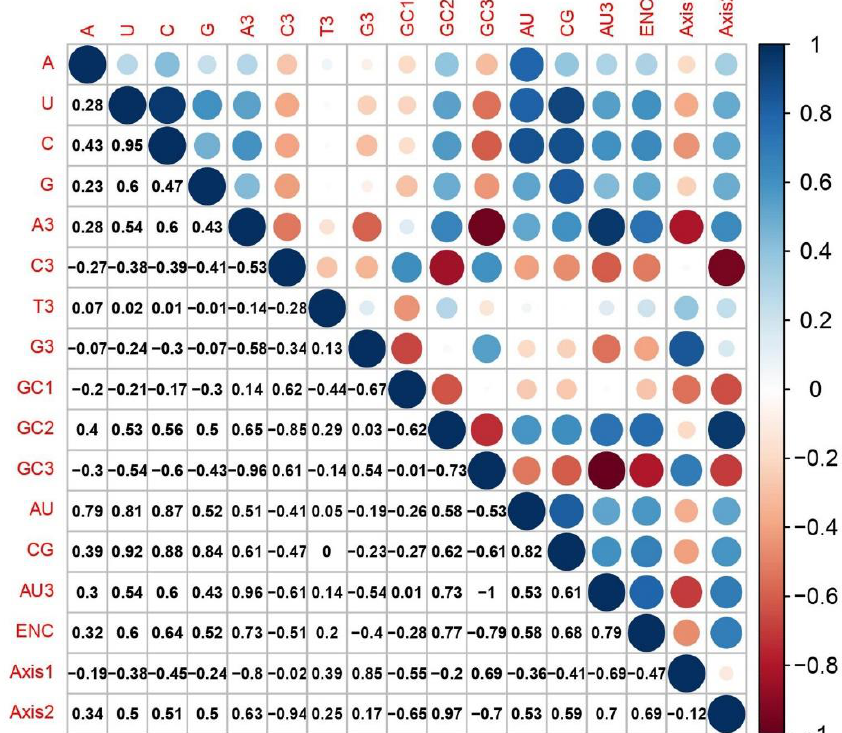
Figure 8. Correlation analysis among different nucleotides contents of RYMVs, and the first two principal axes of COA. The dark blue means positive correlation, and the dark red means negative correlation; the value larger means more significant correlation.